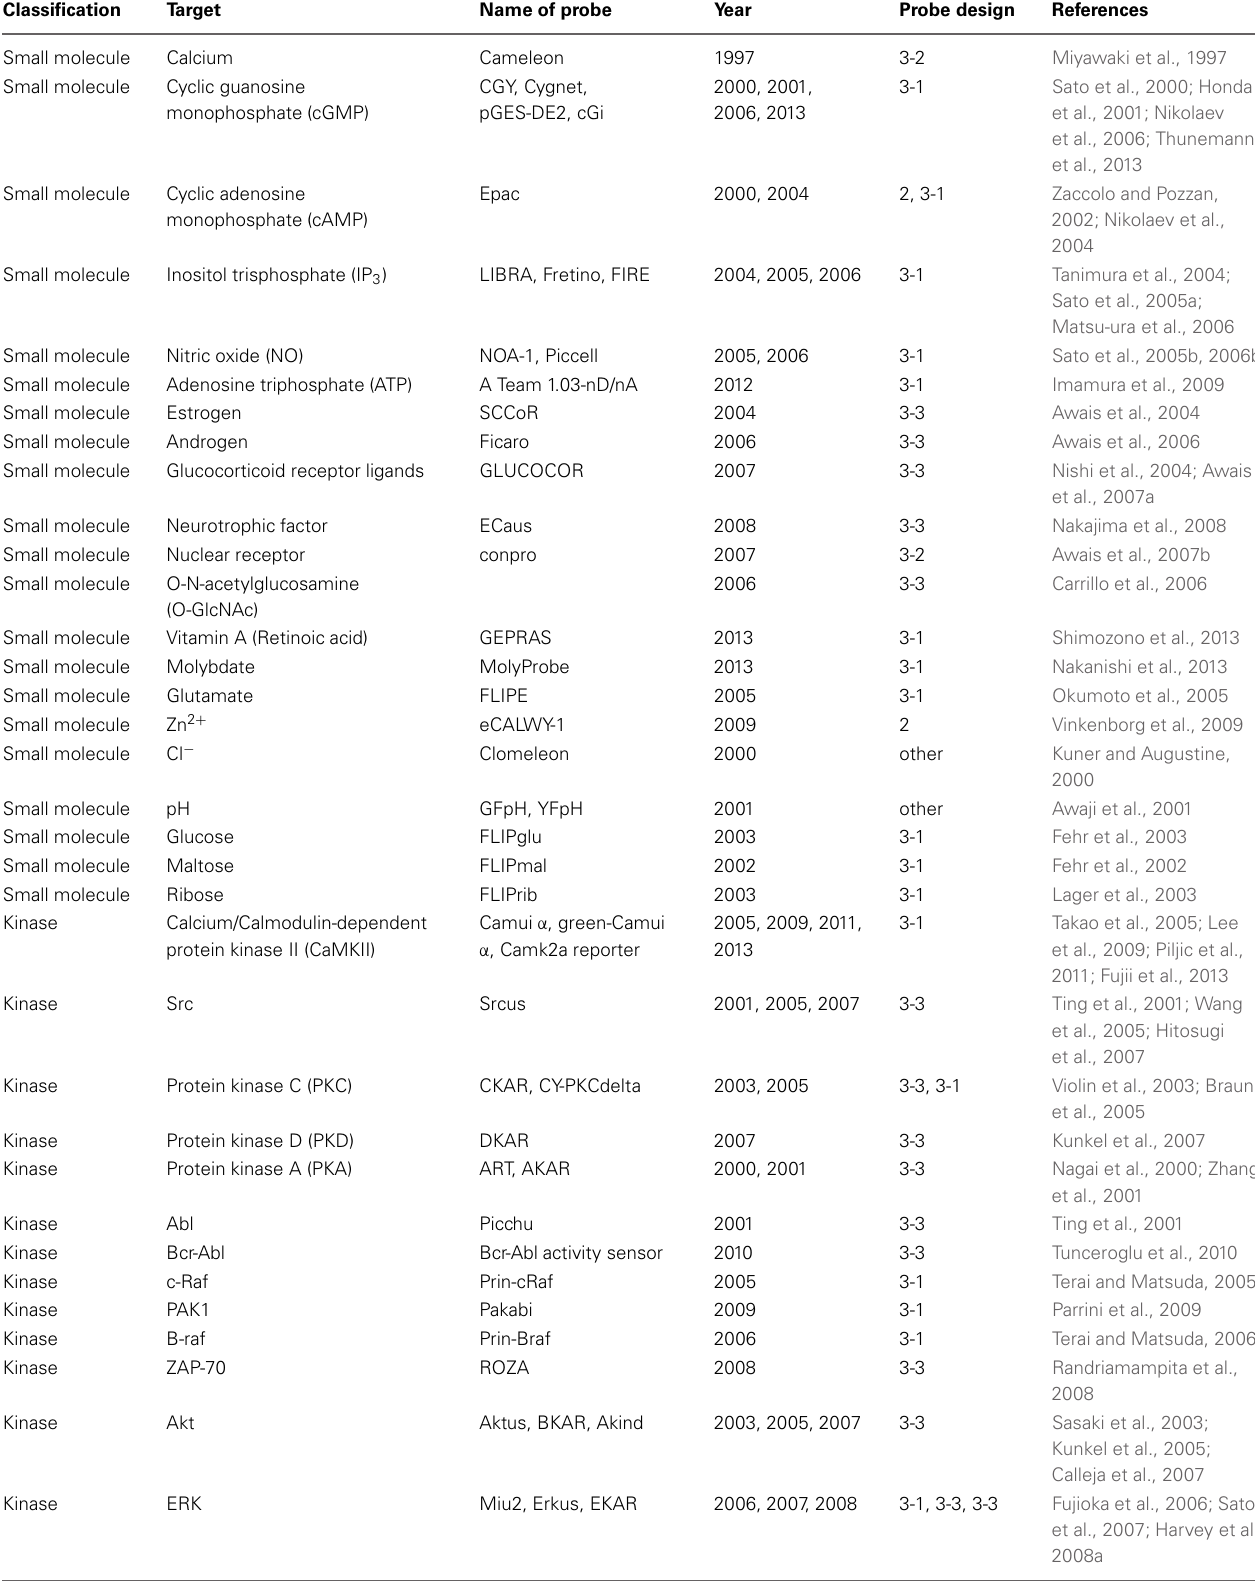
Table 1 | A list of genetically encoded FRET